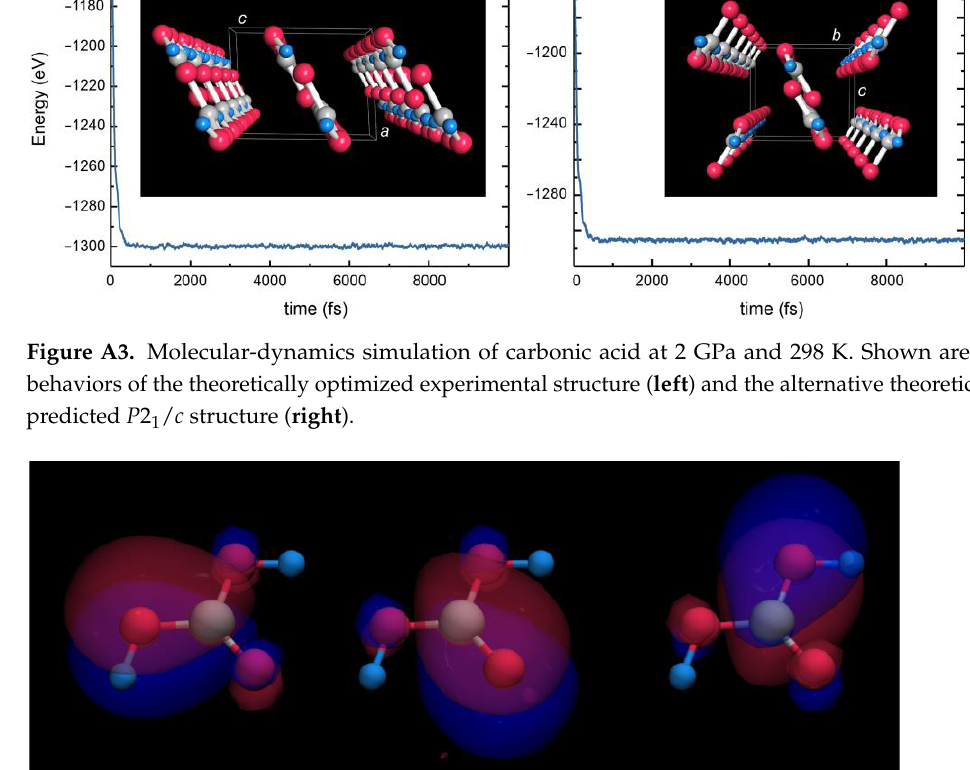
Figure A4. π -bonding molecular orbitals in solid-state carbonic acid. The MOs have been localized from the periodic plane-wave data using an embedding approach (see text).